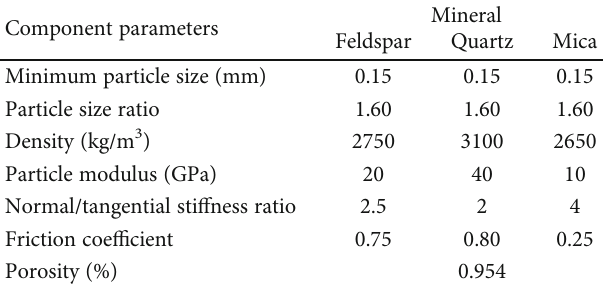
Table 1: Particle mesoscopic